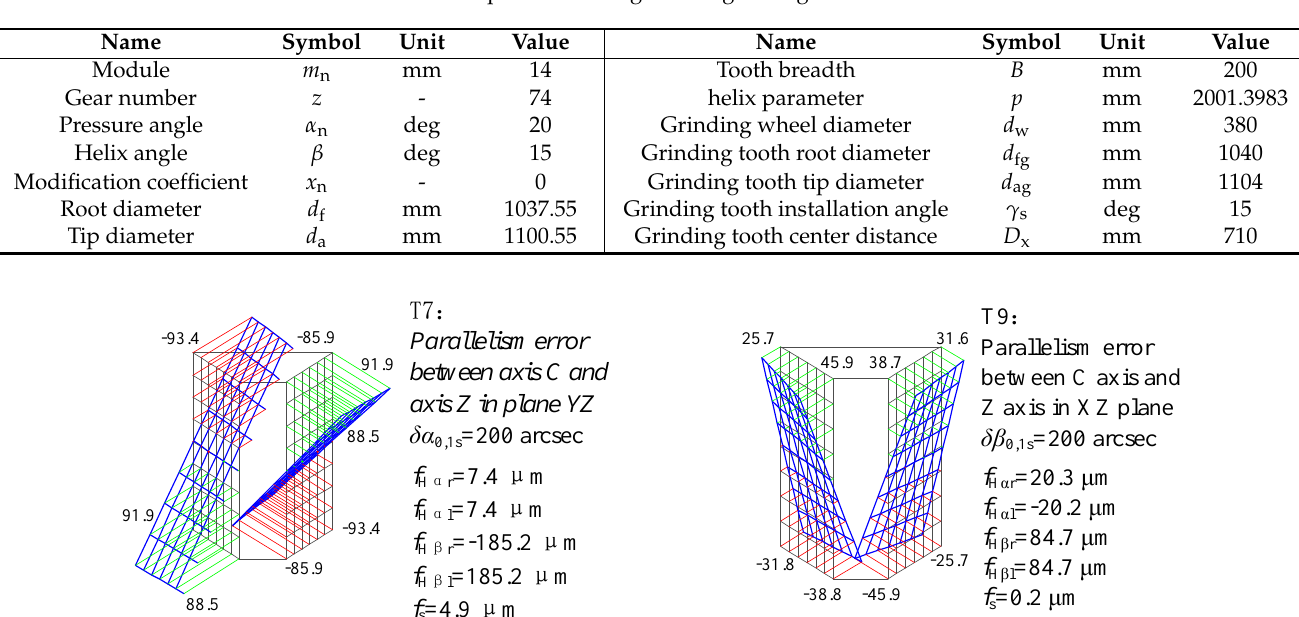
Table 3. Related parameters of gear and grinding wheel.